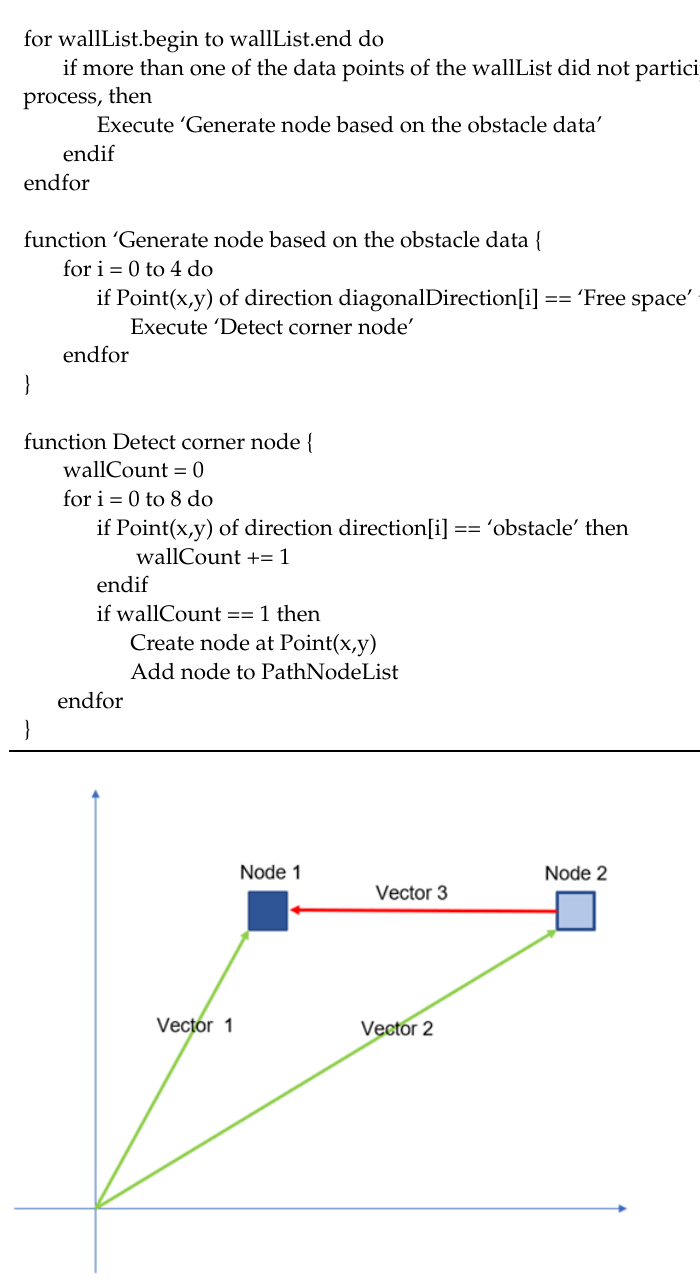
Figure 5. Result of vector subtraction between two vectors. By normalising the newly created Vector 3, Vector 4 with only a direction value for the target node can be generated, as shown in Figure